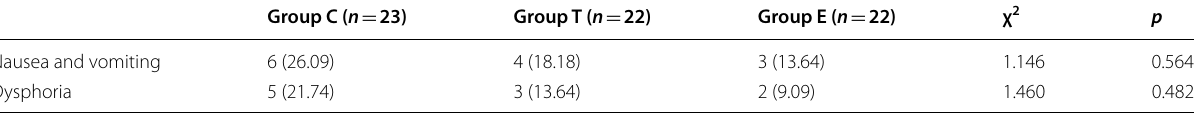
Group C was the control group, group T was the paravertebral nerve block group, and group E was the erector spinal plane block